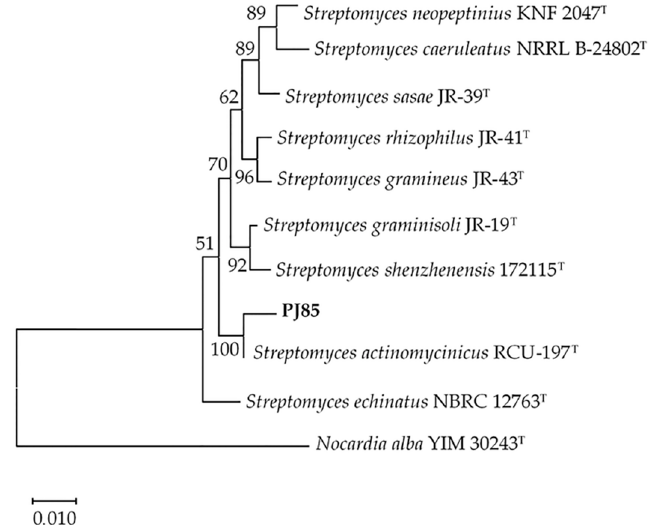
Figure 1. Neighbor-joining phylogenetic tree based on relative 16S rRNA gene sequences showing the phylogenetic relationships among Streptomyces sp. PJ85 and its closest strains. Numbers at nodes indicate bootstrap percentages (1000 replicates), and only values greater than 50% are shown at the nodes. The scale bar indicates 0.01 substitutions per nucleotide position.